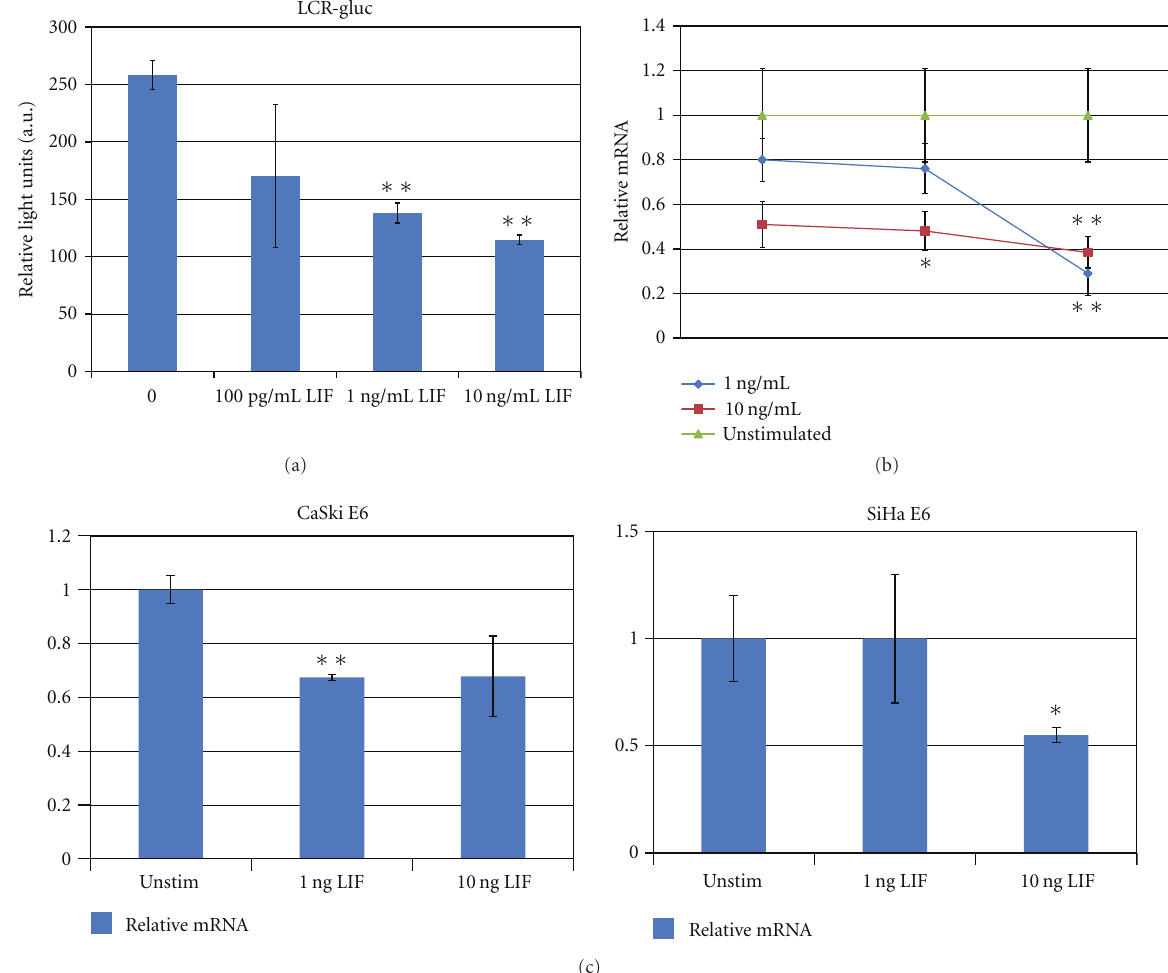
Figure 1: (a) Luciferase expression in LIF-treated and untreated SiHa pGLuc cells. (b) CaSki cells were treated with the indicated concentrations of LIF for 24 hours. Quantitative real-time PCR was performed as described. Error bars represent standard error of the mean. (c) CaSki and SiHa cells were treated with the indicated concentrations of LIF for 72 hours. Quantitation of E6 relative to β -actin is represented in arbitrary units. Error bars represent standard error of the mean. Asterisks represent significance ( ∗ P < . 1, ∗∗ P < .